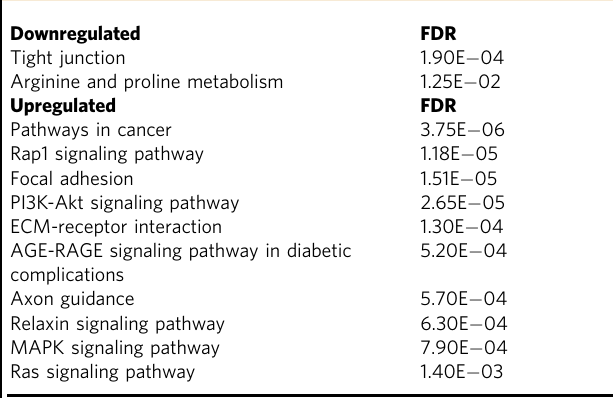
Table 1 Re-growing CTSD-de fi cient tumor cells upregulate oncogenic signaling